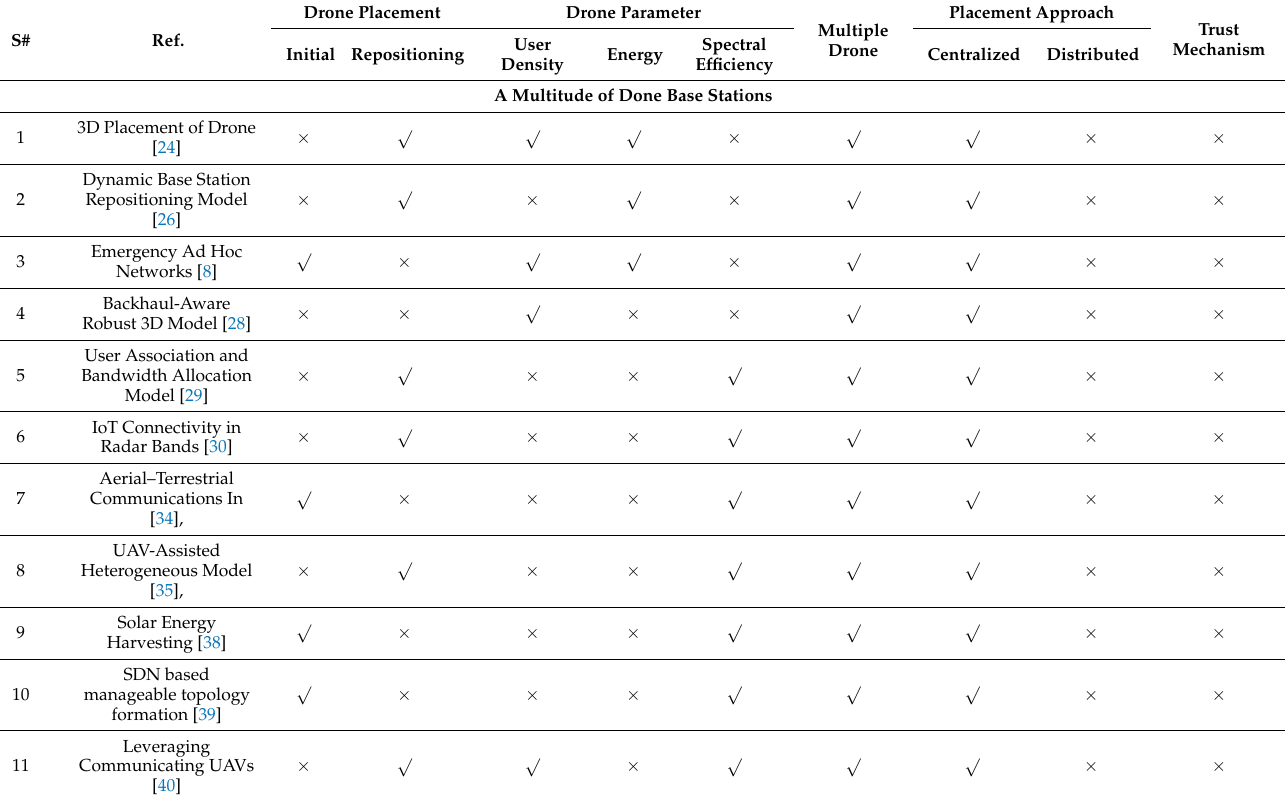
Table 1. Technical comparison of discussed